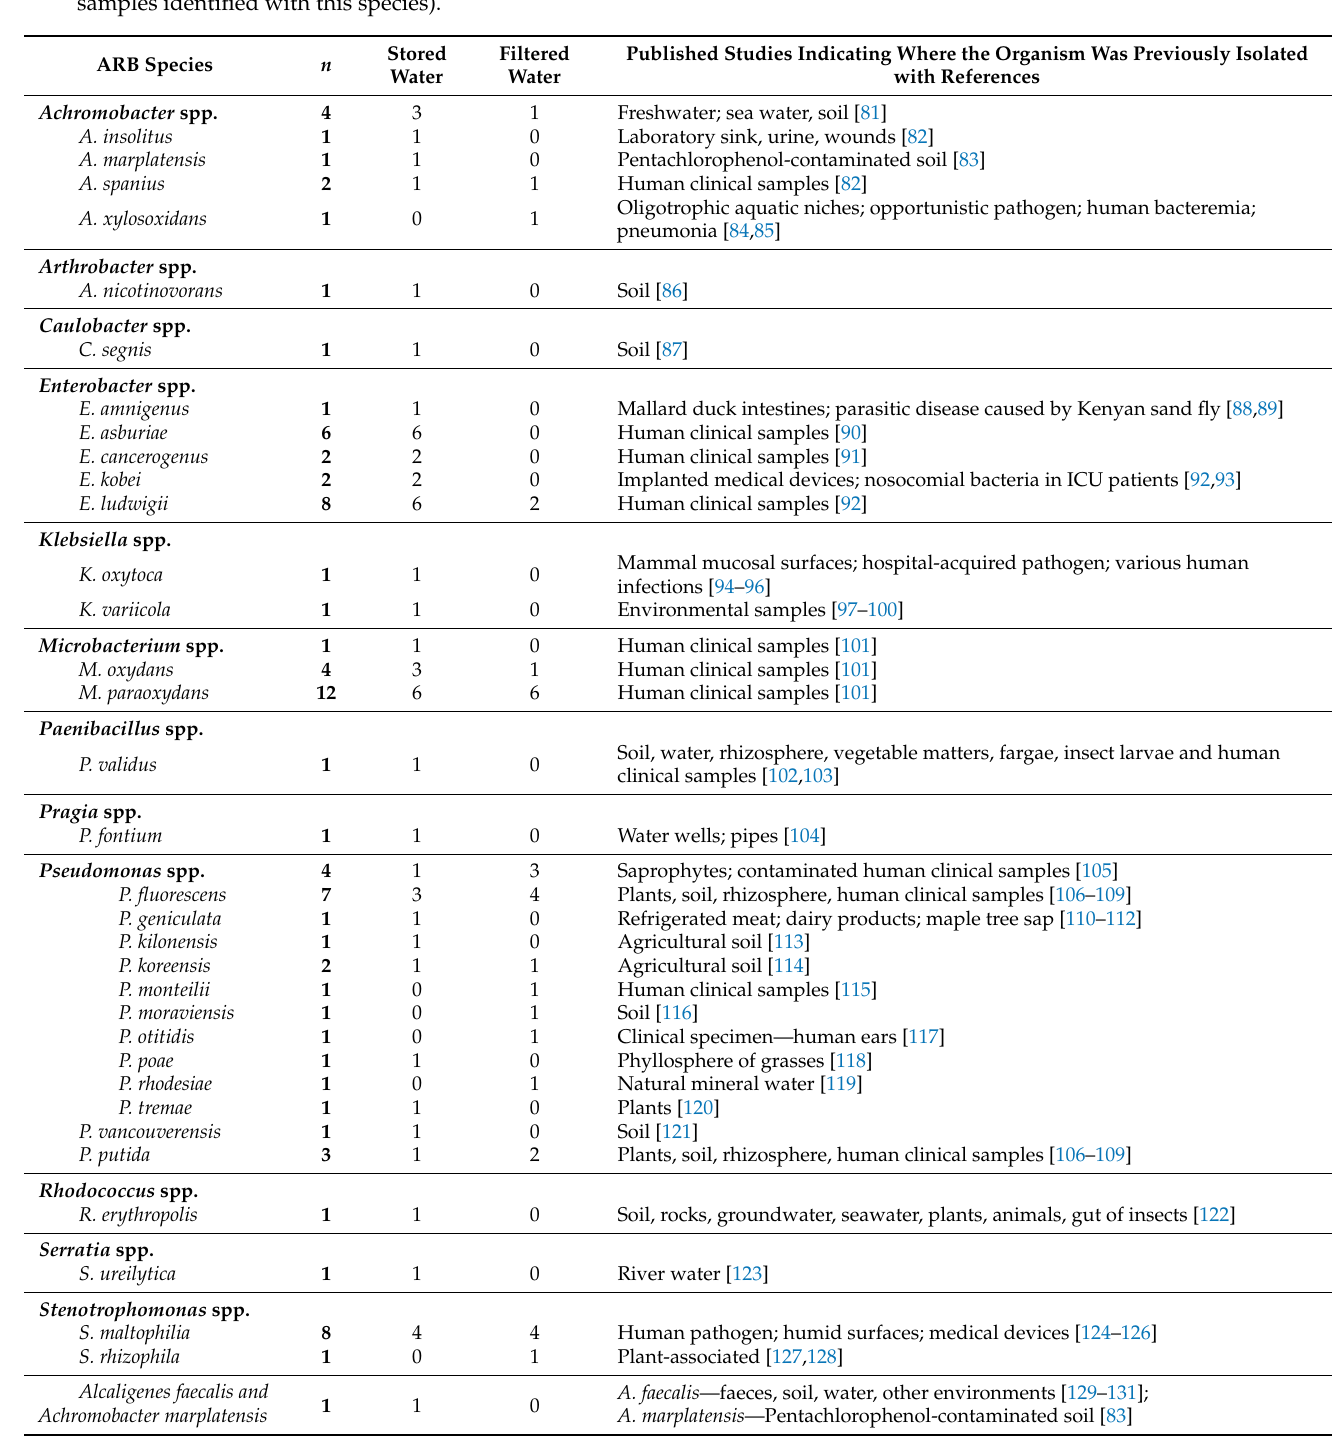
Mycobacterium spp. Some of these species have been identified as human pathogens while some are mainly found in the natural environment (water, soil, and plant samples). Table 3. Amoeba-resistant bacteria (ARB) isolated and identified from household storage container water and the ceramic pot water sources, and information where the organism has been isolated in other reported studies ( n = total number of samples identified with this